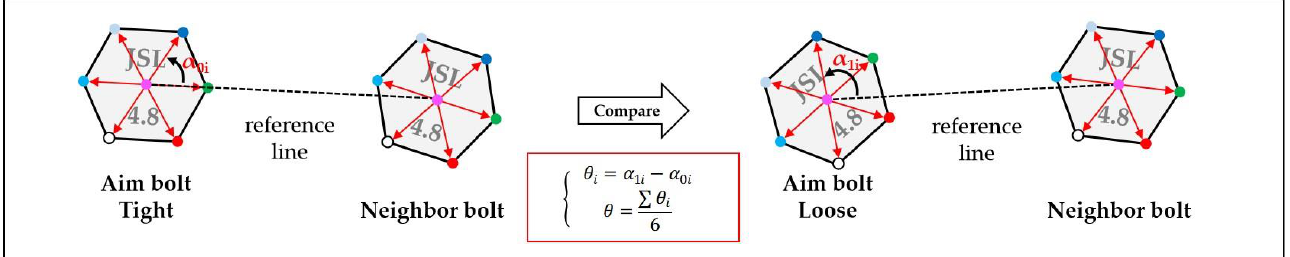
Figure 14. Calculation of the rotation bolt loosening angle.